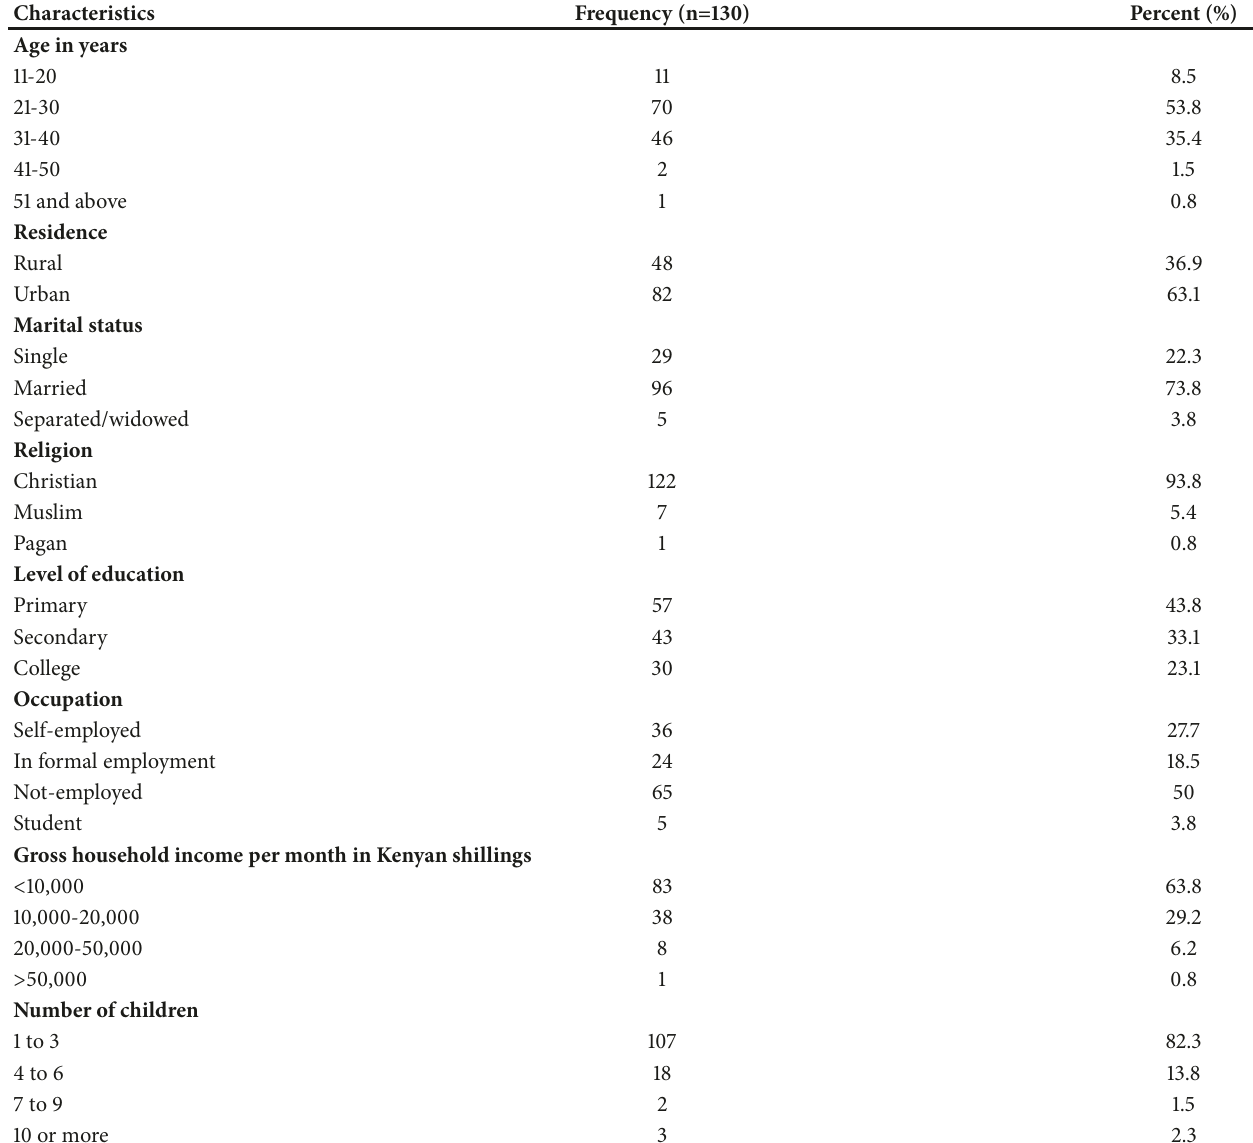
Table 1: Sociodemographic characteristics of the